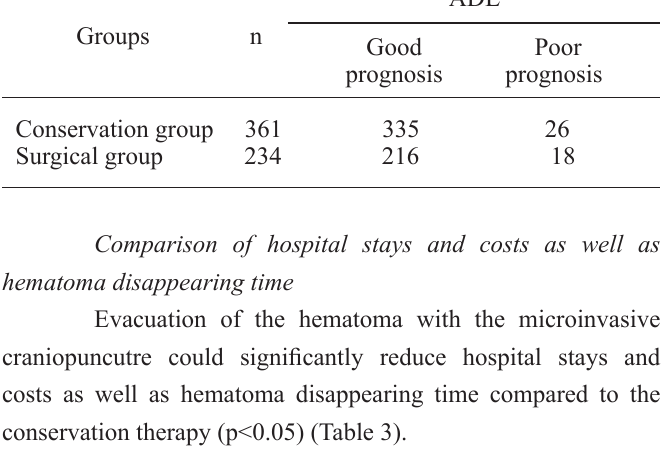
TABLE 3 - Comparison of hospital stays and costs